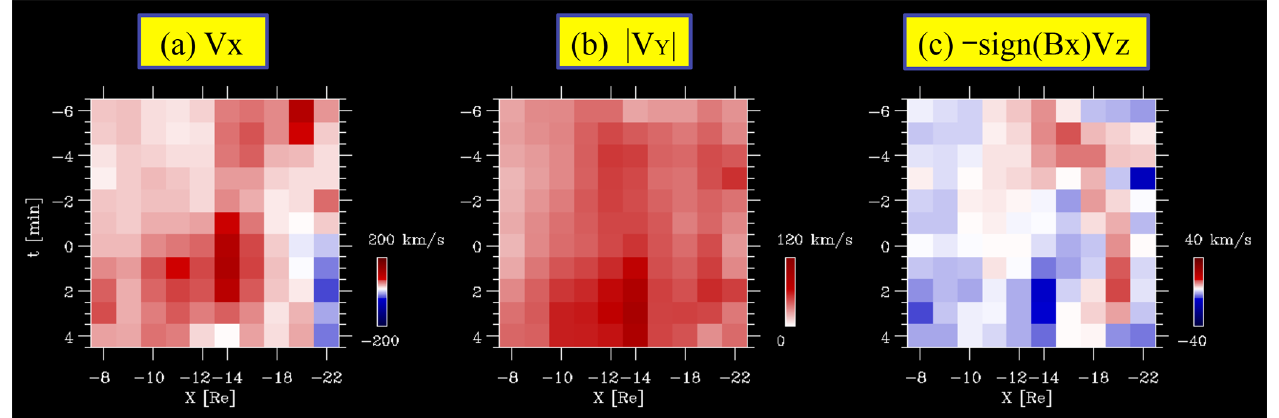
Fig. 6. Time evolution of (a) the earthward-flow velocity, V X ; (b) the dawn-/duskward flow velocity, | V Y | ; and (c) the flow velocity towards the CPS, − sign( B X )V Z , in the equatorial